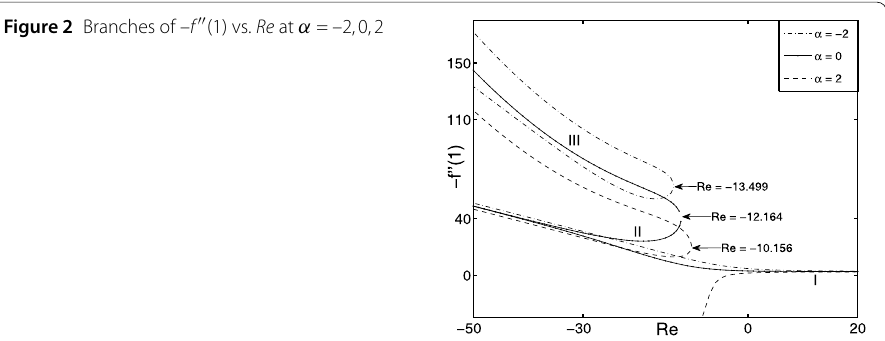
Figure 2 Branches of – f (cid:3)(cid:3) (1) vs. Re at α =